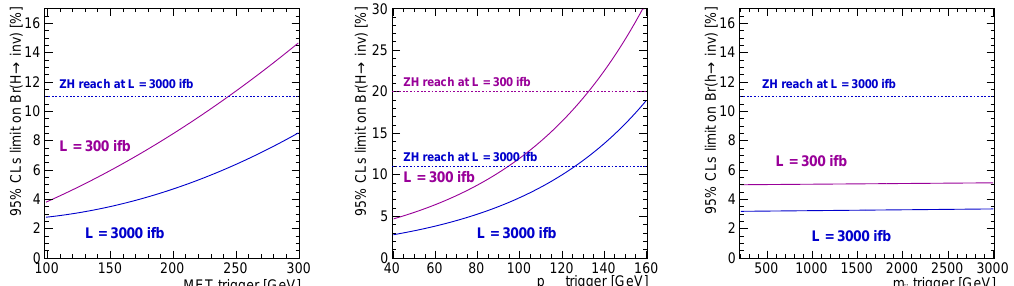
Figure 12: CLs limits on invisible Higgs decays from weak boson fusion, as a function of trigger cuts on missing transverse energy (left), the transverse momentum of the tagging jets (center), and the invariant mass of the tagging jets (right). As a reference we also display the reach in the leptonic ZH channel, described in the